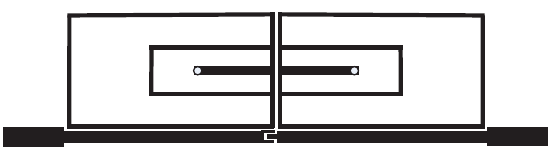
Figure 1: Schematic of the proposed ring